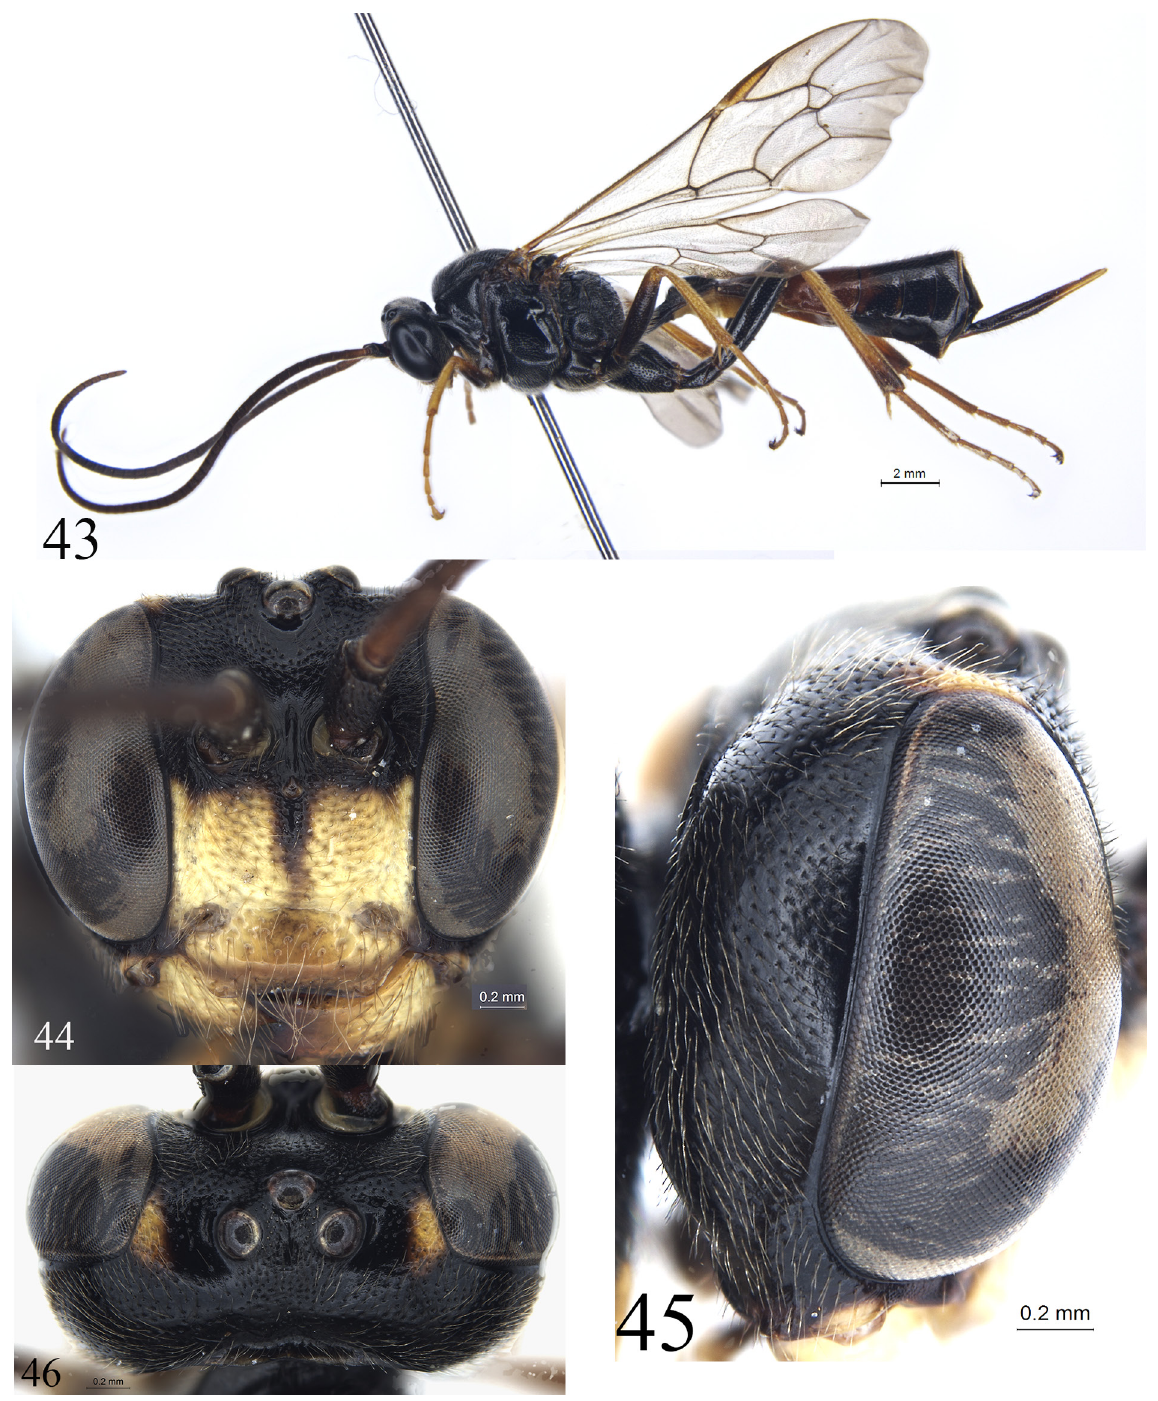
Figs 43–46. Ctenopelma spiraculare Sheng, Sun & Li sp. nov., holotype, ♀ (GSFGPM). 43 . Habitus, lateral view. 44 . Head, anterior view. 45 . Head, lateral view. 46 . Head, dorsal